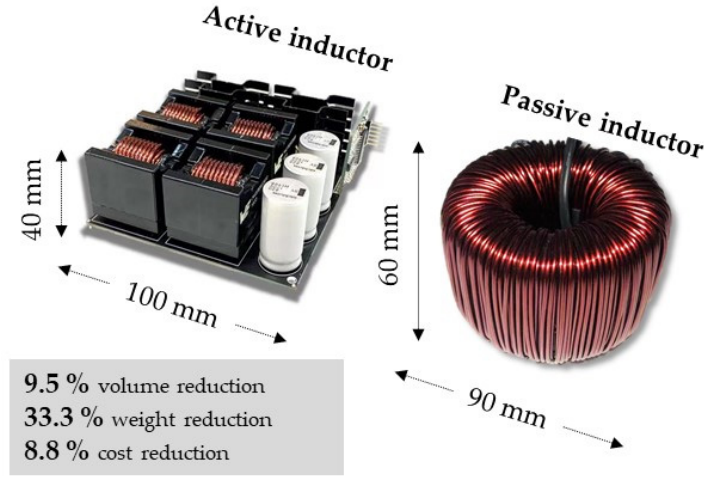
Figure 7. Comparison of the variable active inductor prototype and the passive magnetic inductor prototype built in lab. Table 2. Reliability-oriented component sizing results.